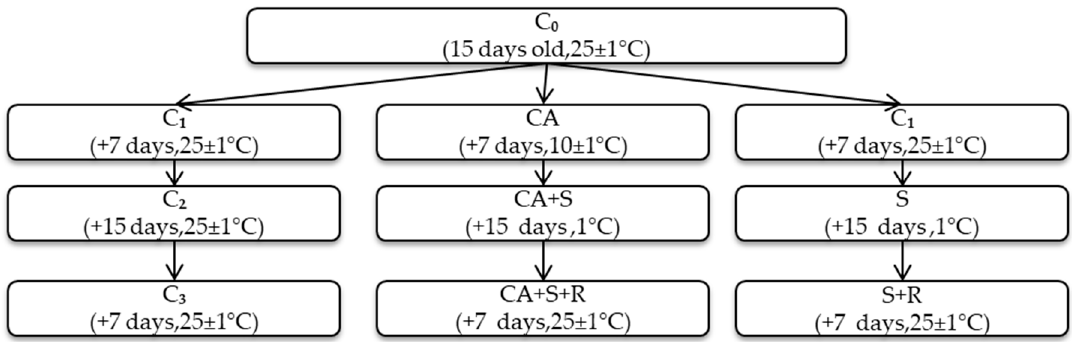
Figure 1. States of the cold stress experiment [25].